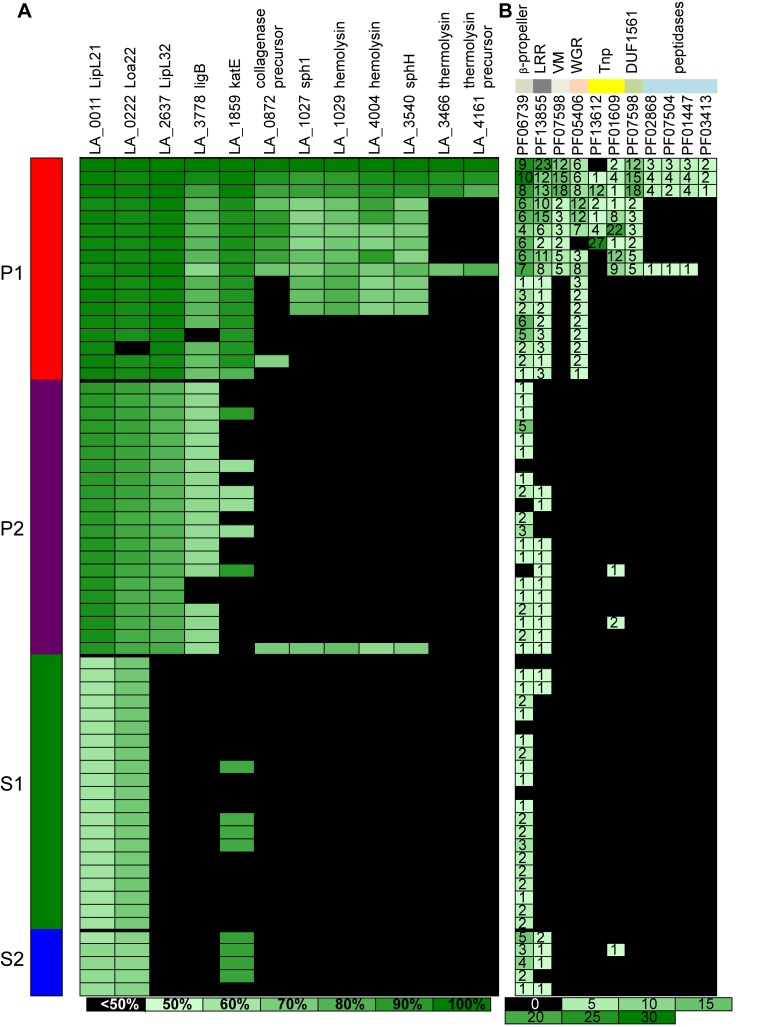
Distribution of genes involved in virulence (A) and PFAM motifs (B). The gradient represents for (A) the percentage of similarity according to the homologous proteins sequences in L. interrogans strain 56601 and for (B) the number of genes having the different PFAM motifs.